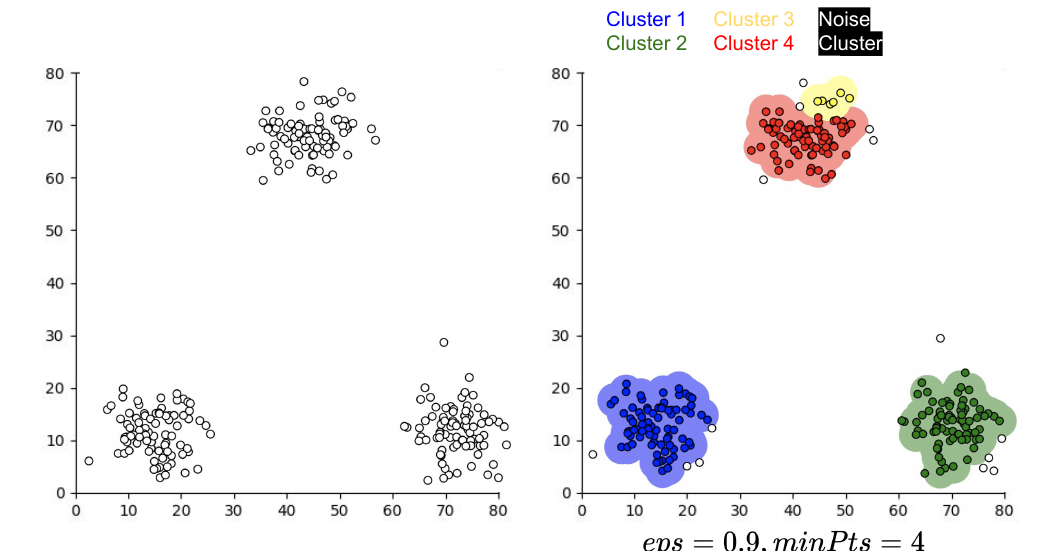
Figure 1. Application of the DBSCAN algorithm to the solution space as an example of